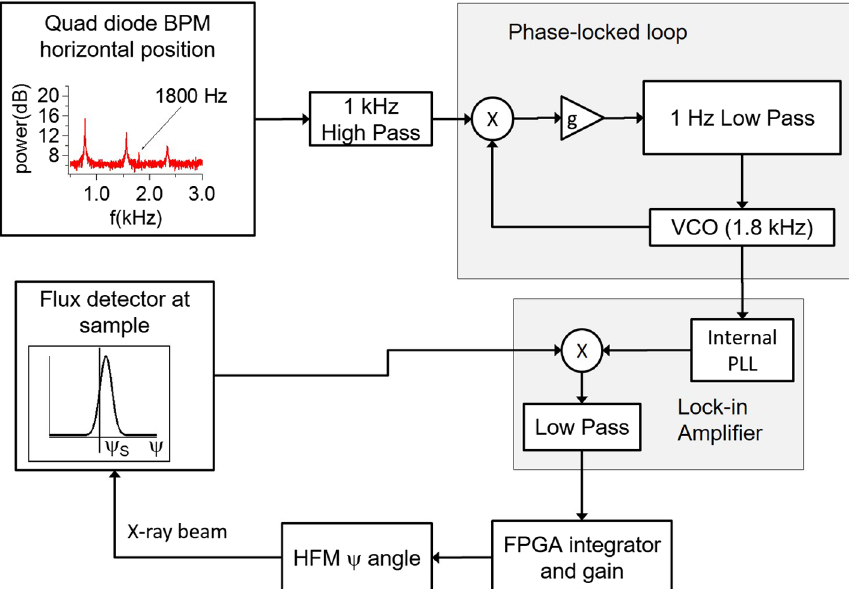
FIG. 2. The phase reference is extracted from the horizontal beam position monitor (BPM) downstream from the DCM using a phase locked loop (PLL) with the voltage controlled oscillator (VCO) centered at 1.8 kHz. The phase locked signal is then fed into the lock-in amplifier (LIA) external reference input. The LIA detects the phase between the reference and intensity oscillations using a digital mixer (multiplication sign). The resultant signal from the LIA is then digitally integrated using a field programmable gate array (FPGA). The integrated signal out of the FPGA is used to control the HFM piezo actuator, steering the beam towards optimal